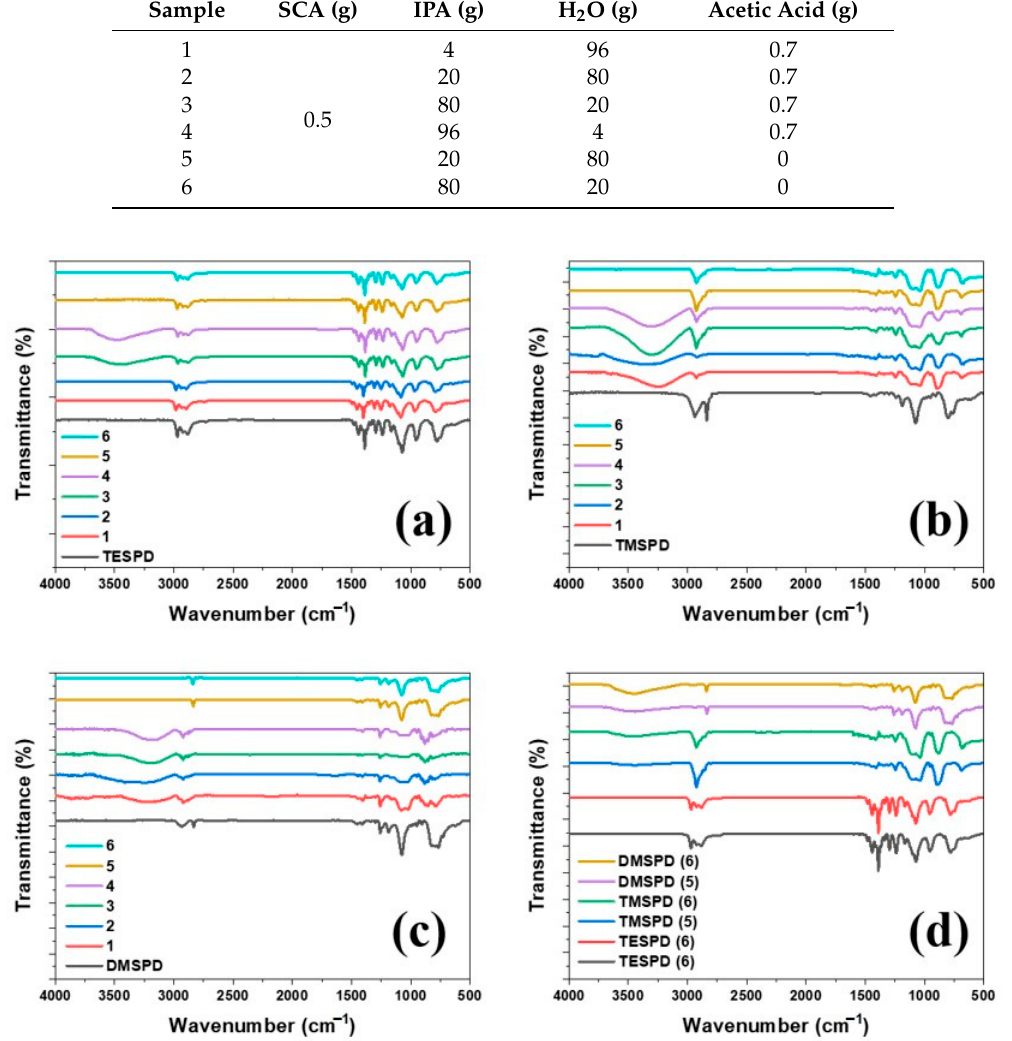
Figure 3. FTIR spectra for 1 h hydrolysis reactions of the SCAs: ( a ) TESPD; ( b ) TMSPD; ( c ) DMSPD; and ( d ) spontaneous reactions of samples 5 and 6 during 10 days.